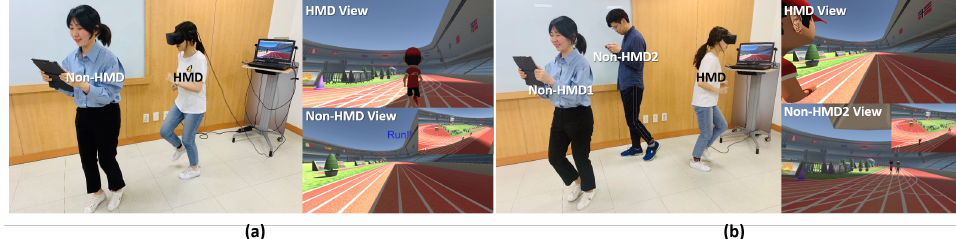
Figure 10. ( a ) One HMD and one non-HMD user can play in the relay running mode. ( b ) One HMD and more than one non-HMD user can play in the general 100 m race mode.